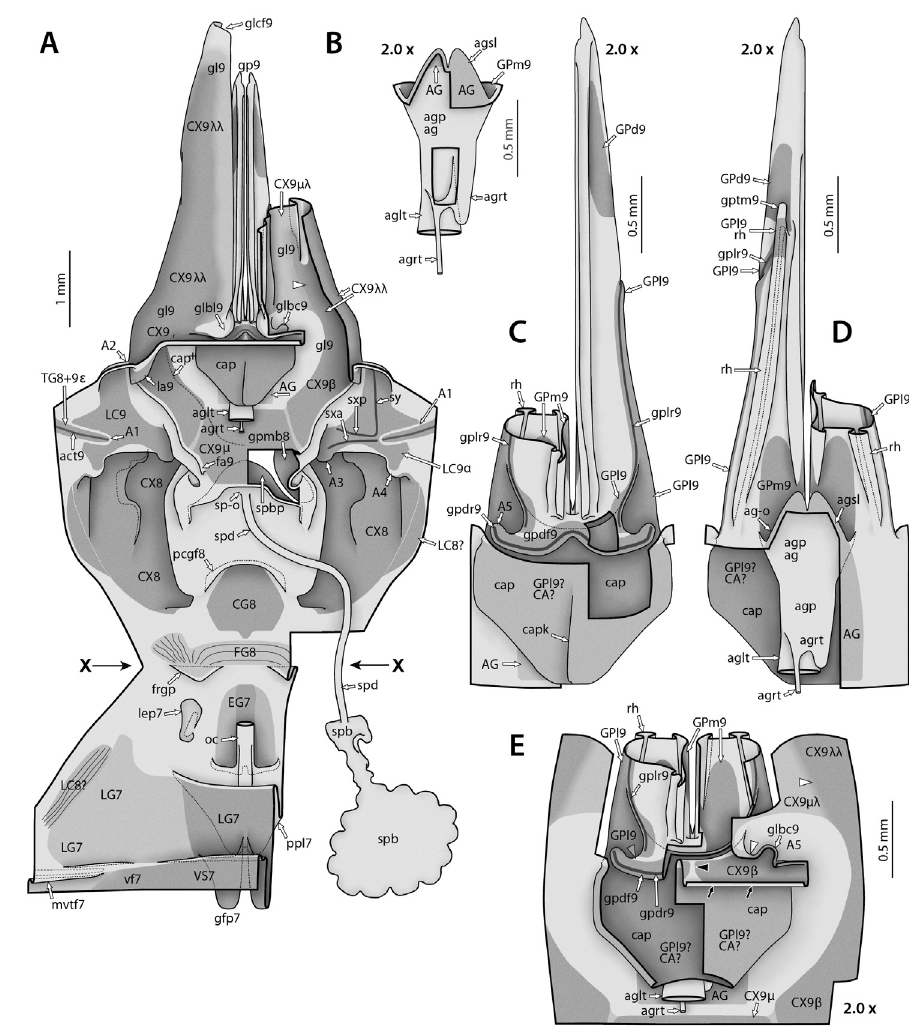
Figure 15. Annotated illustrations of the female Sphodromantis sp. postabdomen and genitalia for mor- phological use. A genital region, most parts in internal view. Posterior parts (segments VIII, IX) are bent 180° dorsally and to the anterior compared to anterior parts (of segment VII), along the axis marked by arrows X. The lower half of the illustration shows part of the dorsal wall of the ventral fold 7 (“subgenital lobe”) and genital fold area in ventral view; the upper half of the picture shows the ventral sides of seg- ments VIII and IX in dorsal view. Right gonoplac 9 cut open B accessory gland with some structures sur- rounding its opening C gonapophyses 9 and structures around their base in dorsal view, left gonapophysis 9 cut near base (accessory gland not included) D gonapophyses 9 and structures around their base in ventral view, left gonapophysis 9 cut near base, outlet tubes of accessory gland ( aglt, agrt ) cut near base E base of gonapophyses 9 (right gonapophysis 9 cut open) together with central apodeme and adjacent parts of coxa 9 sclerotizations and gonoplacs 9. Thick black lines are (virtual) cutting